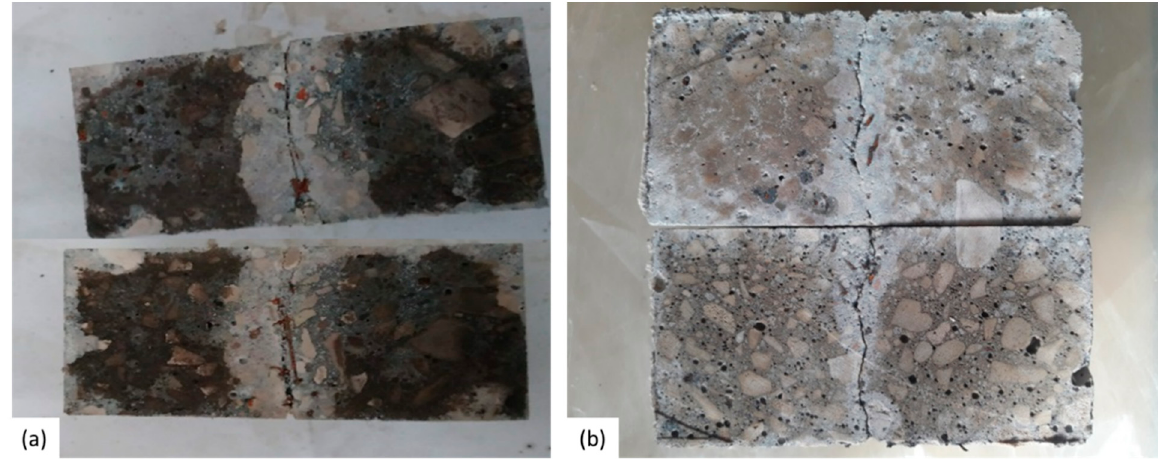
Figure 5. Indicative chloride penetration colorimetric assessment of ( a ) REF and ( b ) ADD specimen.